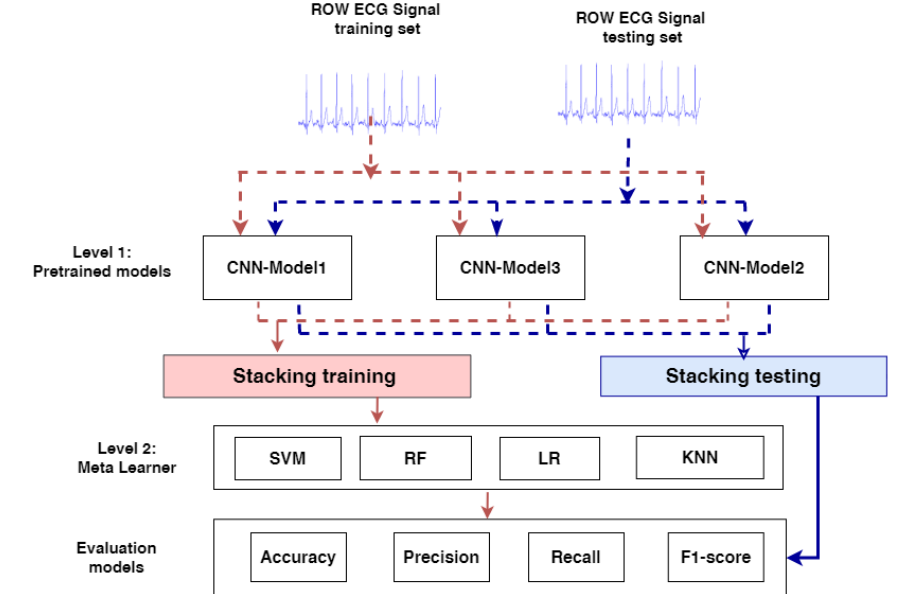
Figure 2. The proposed model for prediction